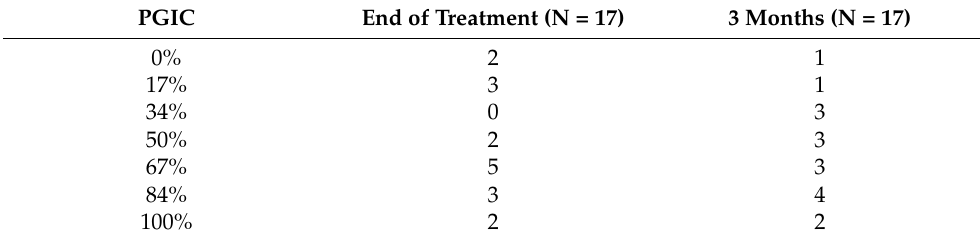
Table 2. PGIC scores at the end of treatment and 3 months after the end of treatment.